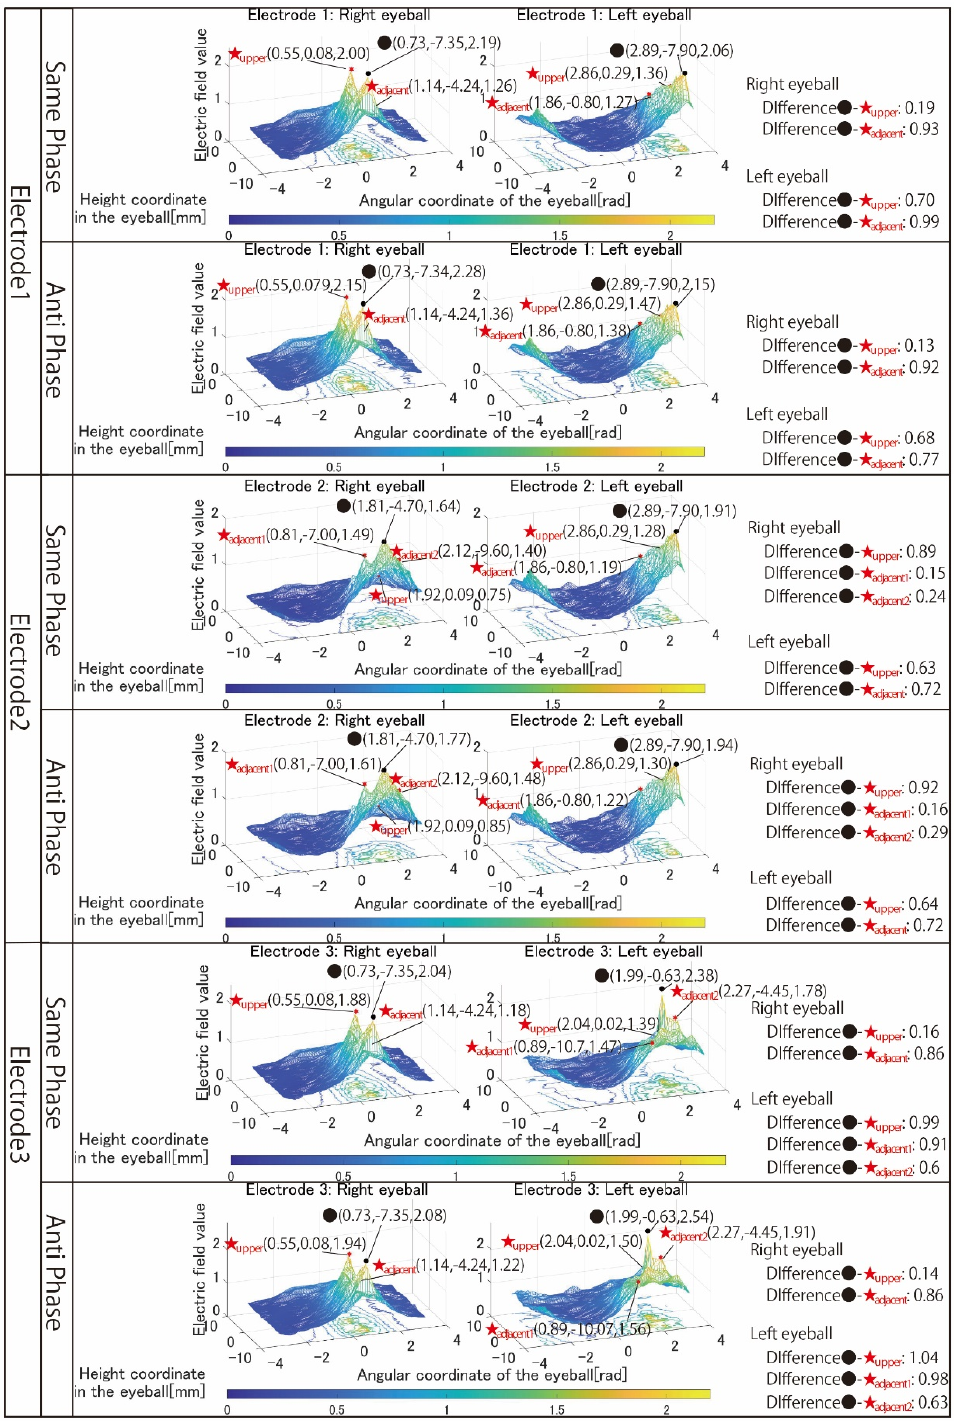
Figure 6. Simulation results with the electrode arrangement to stimulate both eyeballs. The x -axis of all results is the angular coordinate, the y -axis is the height coordinate, and the z -axis is the electric field value. The maximum value of the Z -axis is the optimum value for the simulation content, but the colors of the mesh that change depending on the electric field value are all fixed. This makes it possible to clarify the change in the electric field value due to the difference in the stimulation factors from the color of the mesh,